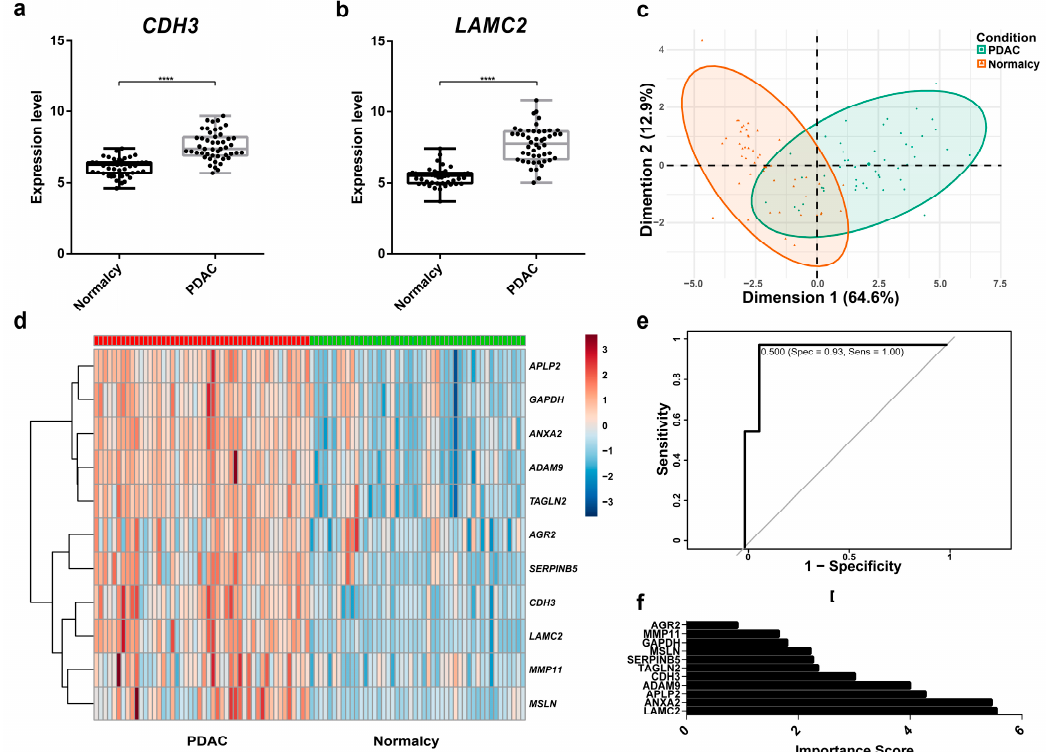
Figure 3. Data exploration and diagnostic performance of 11 biomarker candidates in the Random Forests model. ( a ) The gene expression of CDH3 is higher in PDAC than in normal controls ( n = 96), ****: p < 0.0001. ( b ) The gene expression of LAMC2 is higher in PDAC than in normal controls ( n = 96). ( c ) Principal component analysis of PDAC versus normal controls. ( d ) Heatmap analysis of 11 biomarker candidates. ( e ) ROC curve of the random forests model in the test set ( n = 28). ( f ) The importance scores of 11 biomarker candidates in the random forests model.